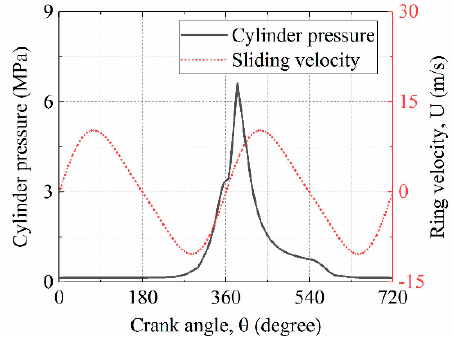
Figure 7. Pressure in cylinder and ring velocity adopted in the simulation.